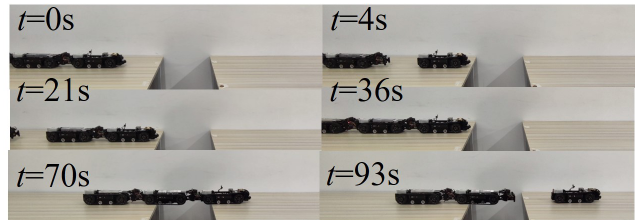
Figure 20. One sensor module, docking with two motion modules in the process of self-assembly, pass over a gap.